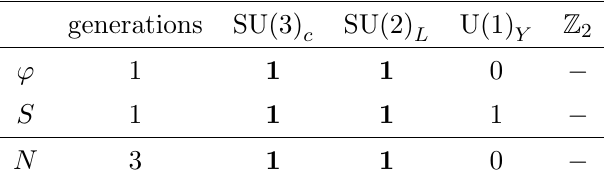
Table 7 . New particles in the AKS model with respect to the